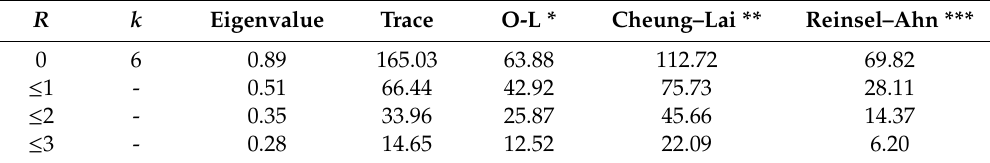
Table 6. Johansen cointegration test.